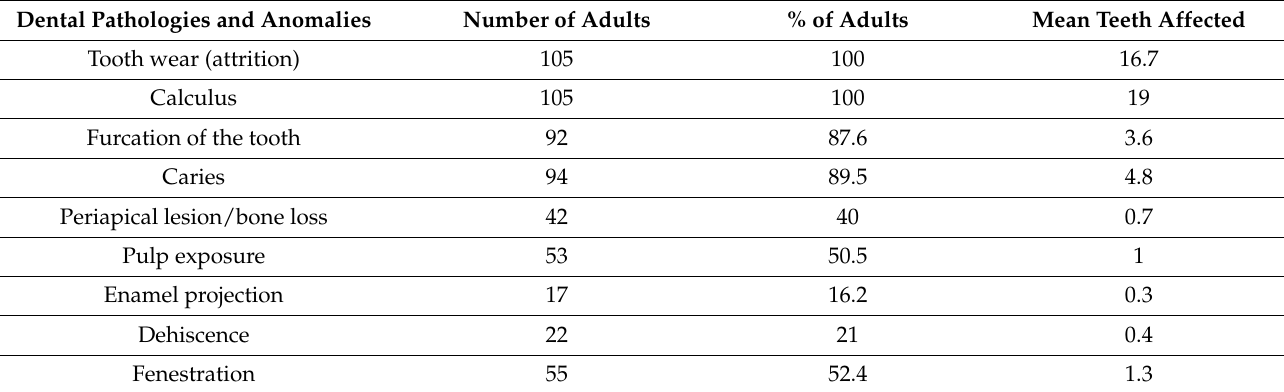
Table 7. Dental pathologies and anomalies.